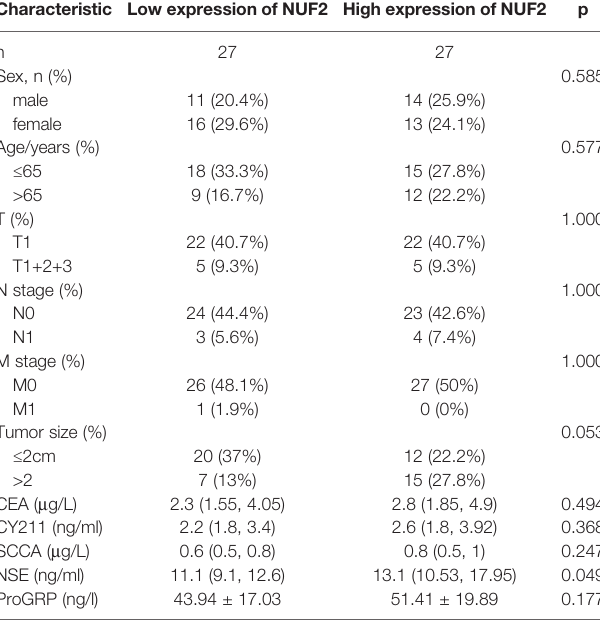
TABLE 2 | Relationship between NUF2 expression and clinicopathological parameters of